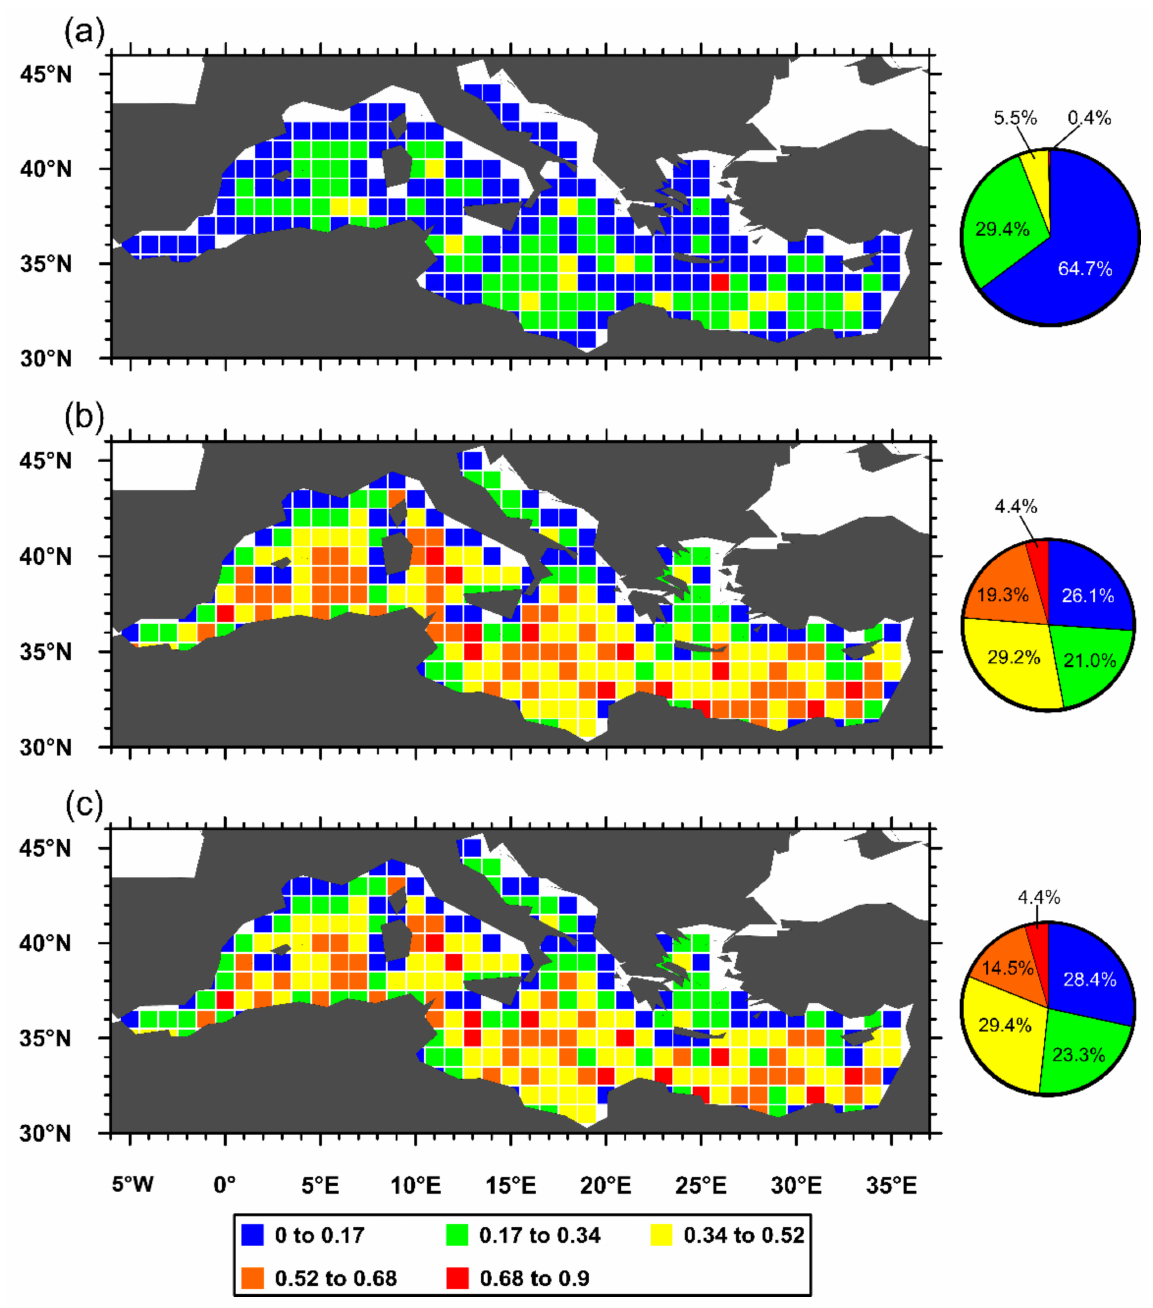
Figure 3. Eddy density distribution maps and density ratio pie charts for the Mediterranean Sea: ( a ) 1/4 ◦ ; ( b ) 1/8 ◦ all-sat; ( c ) 1/8 ◦ two-sat. The colored squares represent the range of eddy density, as shown in the legend. The color pie charts represent the proportion of each density